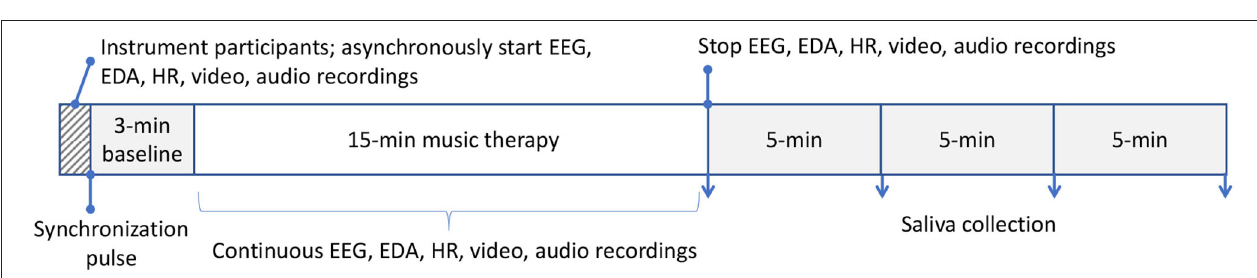
FIGURE 2 | Sessional protocol. All data streams were synchronized with an external sync pulse. Saliva was collected post-session. Only EEG data are reported here. Each of the 10 sessions per participant followed the same protocol. EEG, electroencephalography; EDA, electrodermal activity; HR, heart